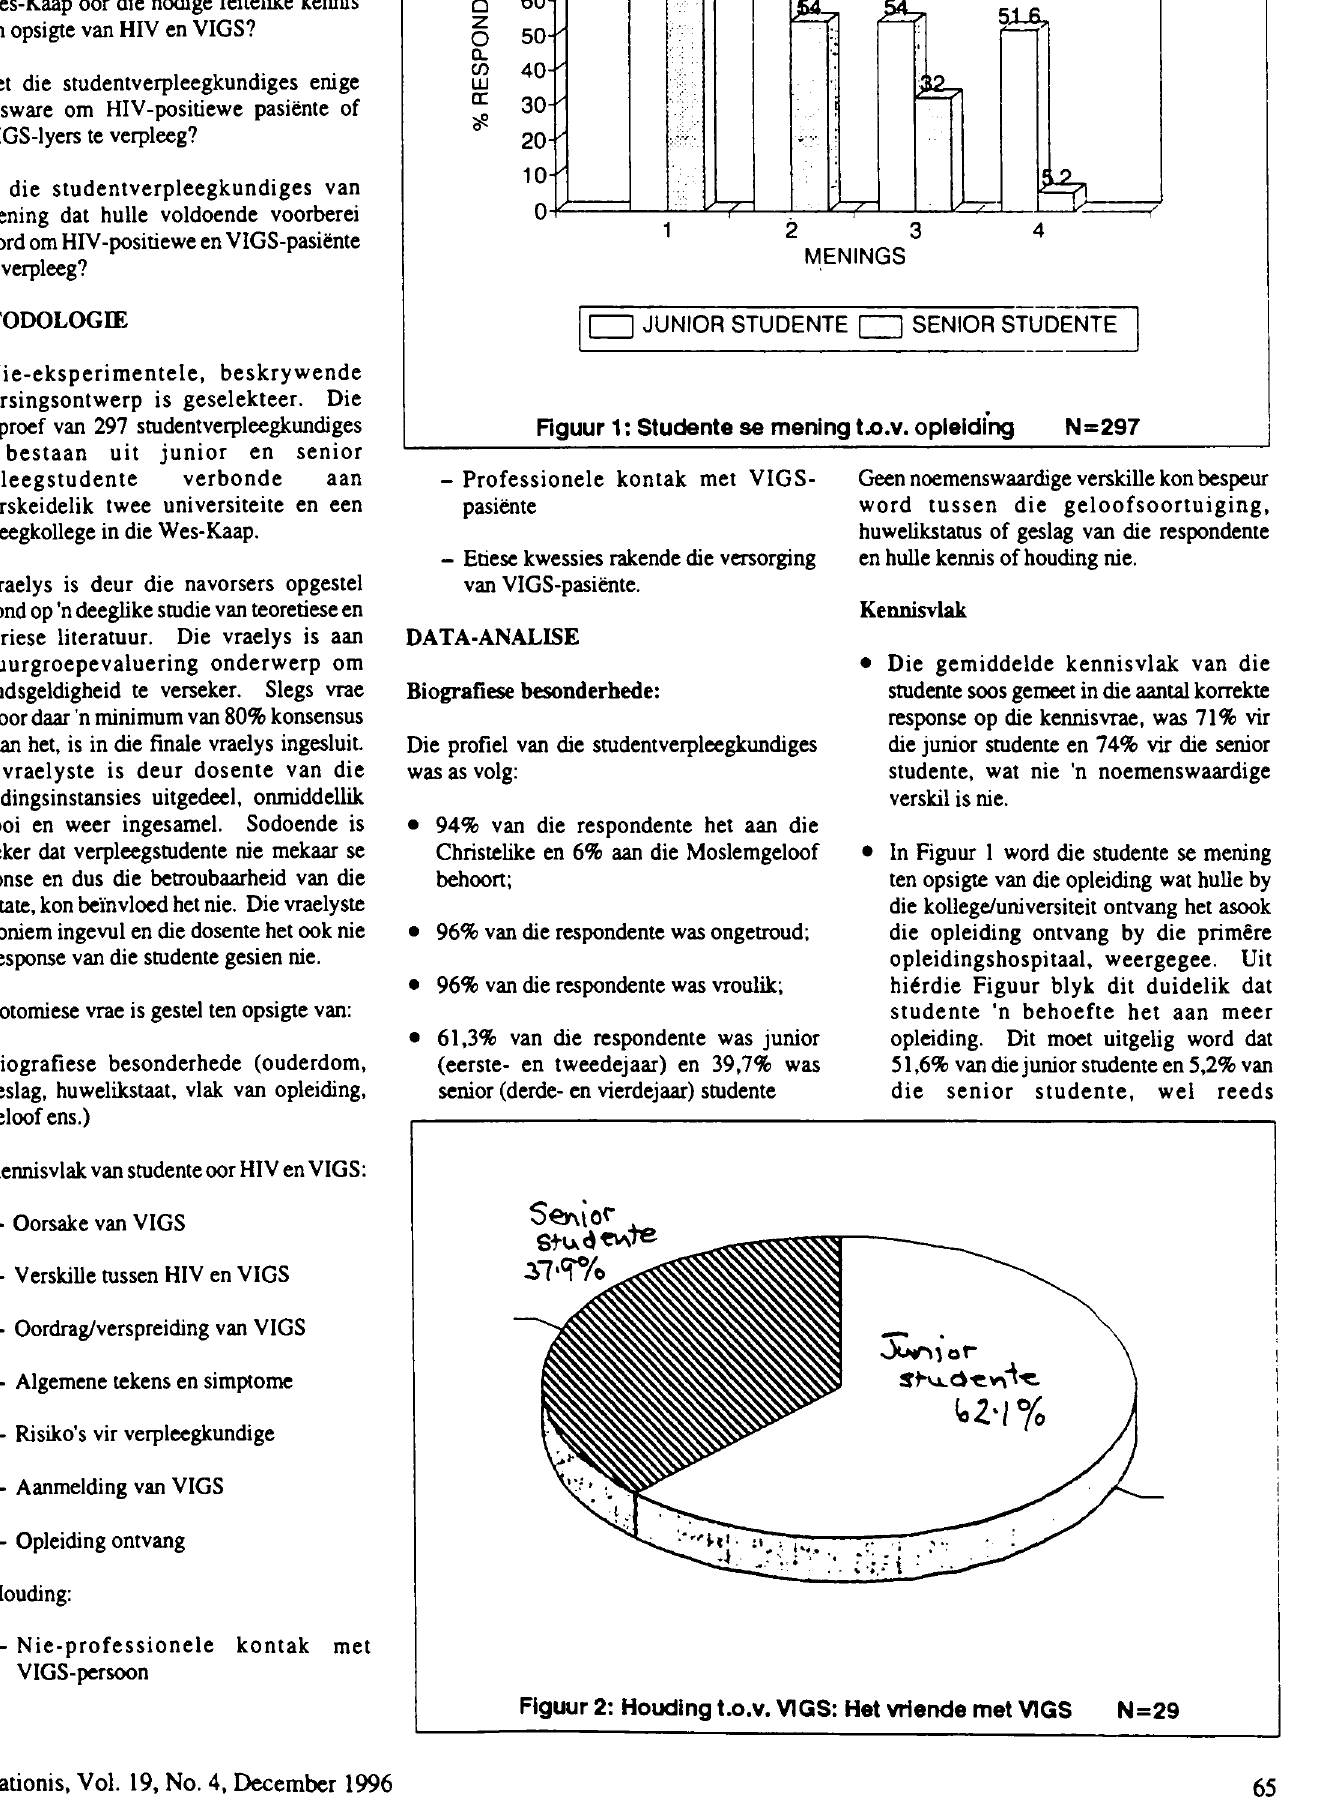
Figuur 1: Studente se mening t^.v. opleiding N=297